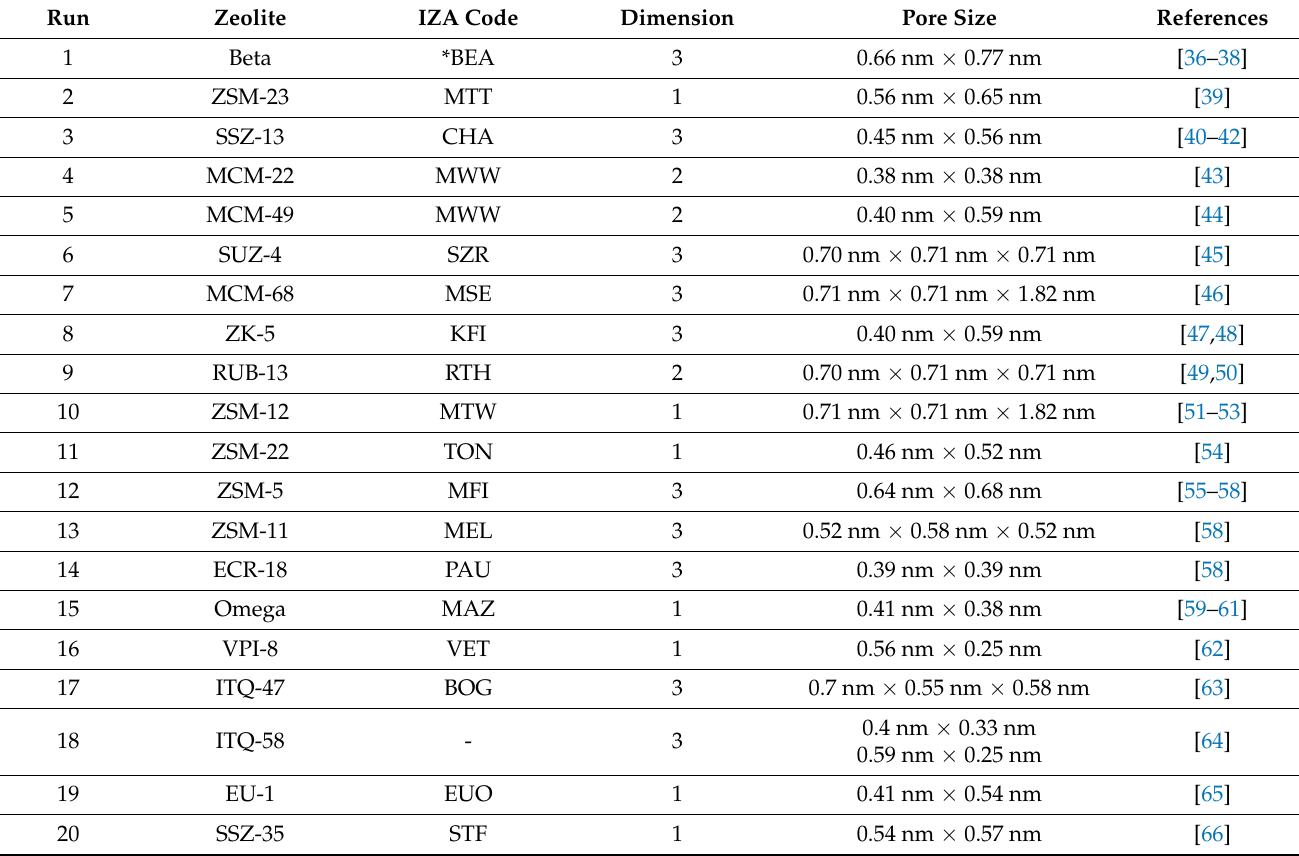
Table 1. List of zeolites prepared from the seed-directed route and their